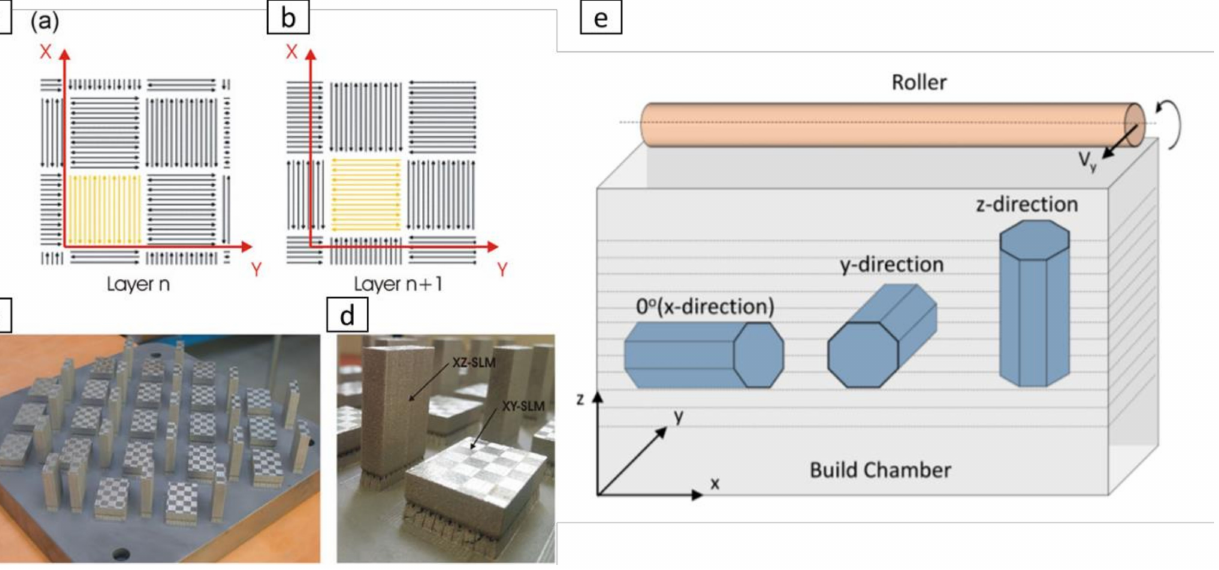
Figure 3. Various scanning directions used for 316L SS ( a – d ) [76] and 304L SS ( e ) reprinted/adapted with permission from Fanshanu et al.